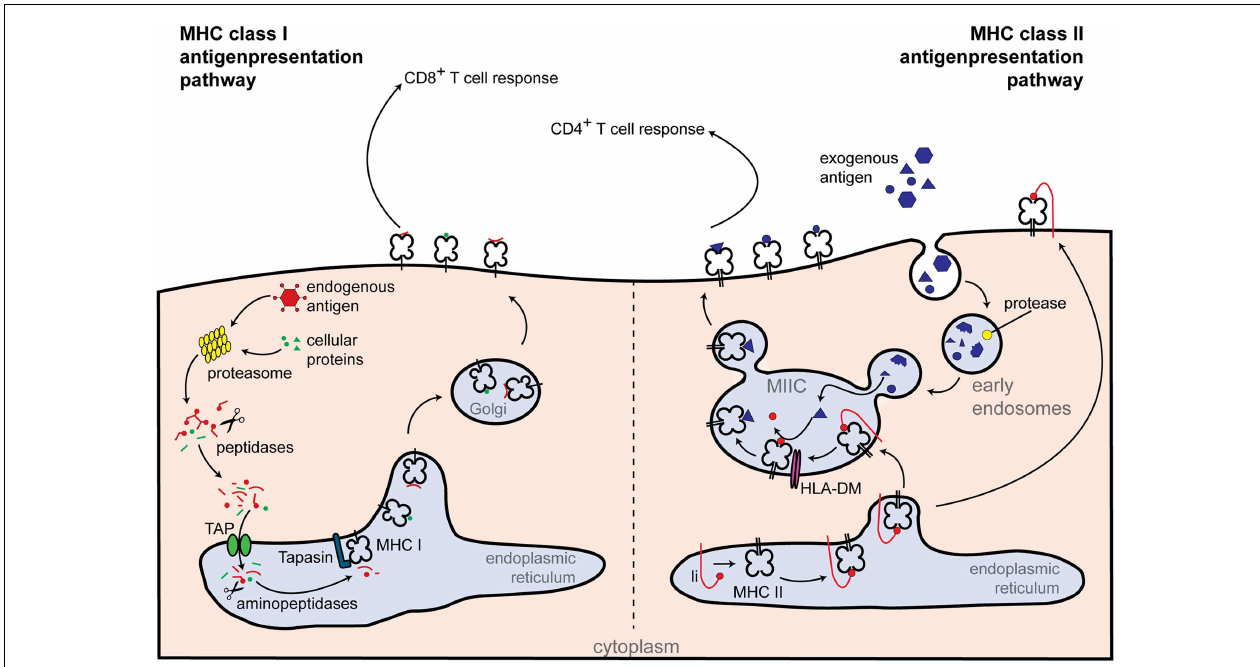
fuse with lysosomes, which contain proteolytic enzymes that cleave the phagocytosed proteins into small peptides. Newly synthesized MHC class II molecules from the endoplasmic reticulum are delivered to the phagolysosomes and loaded with peptide. Peptide-loaded MHC class II complexes are transported to the cell surface, allowing antigen presentation to CD4 + T cells. Additional abbreviations: Ii, MHC class II-associated invariant chain; MIIC, MHC class II compartment;TAP, transporter associated with antigen